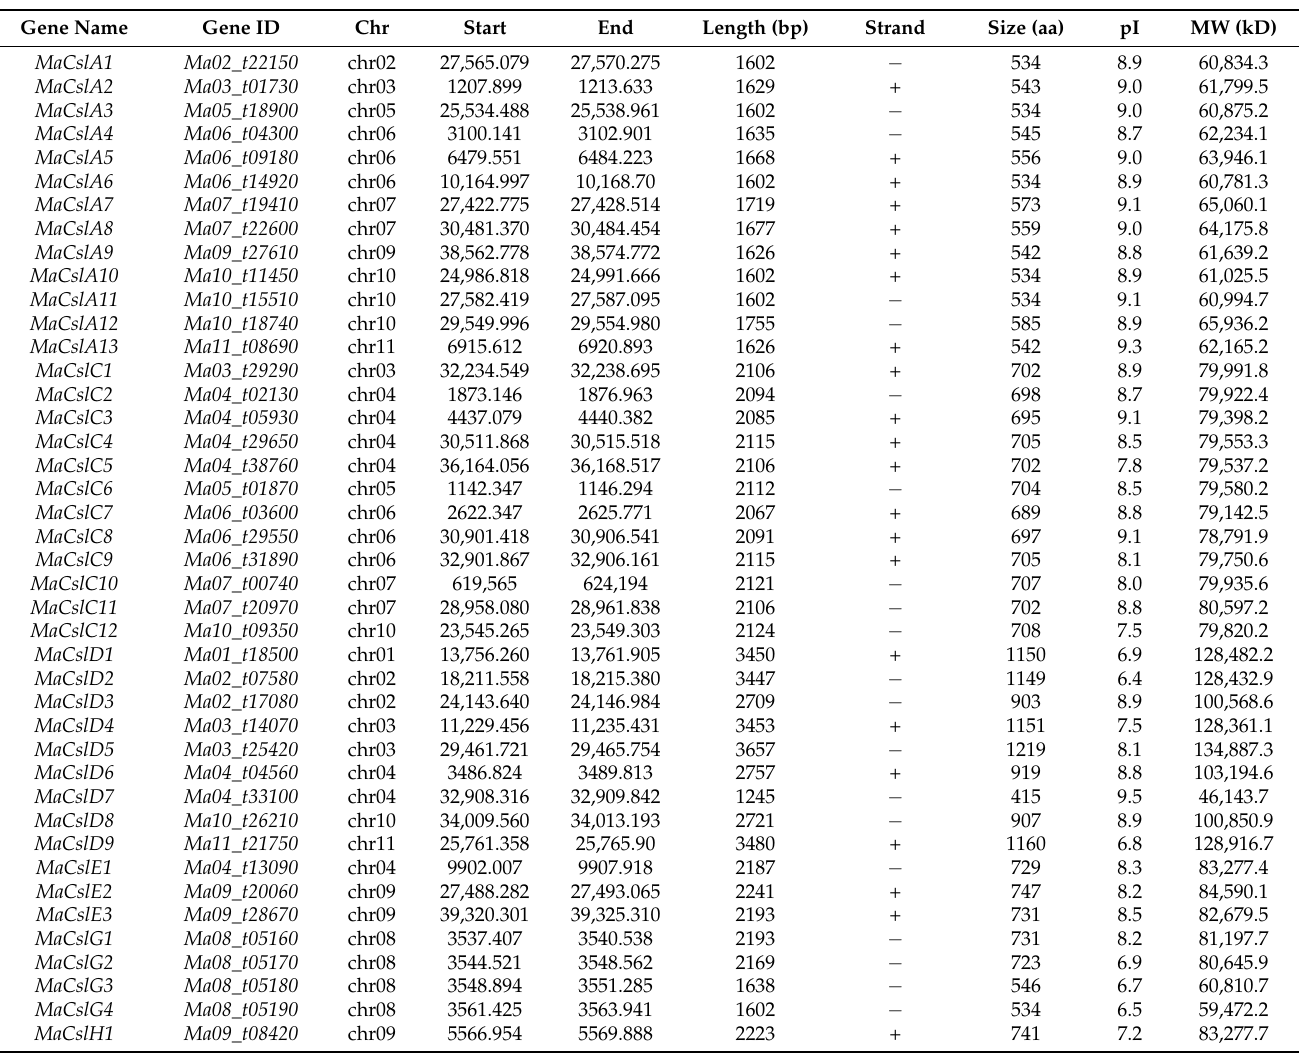
Table 1. 42 MaCsl genes identified in Musa acuminata and their sequence